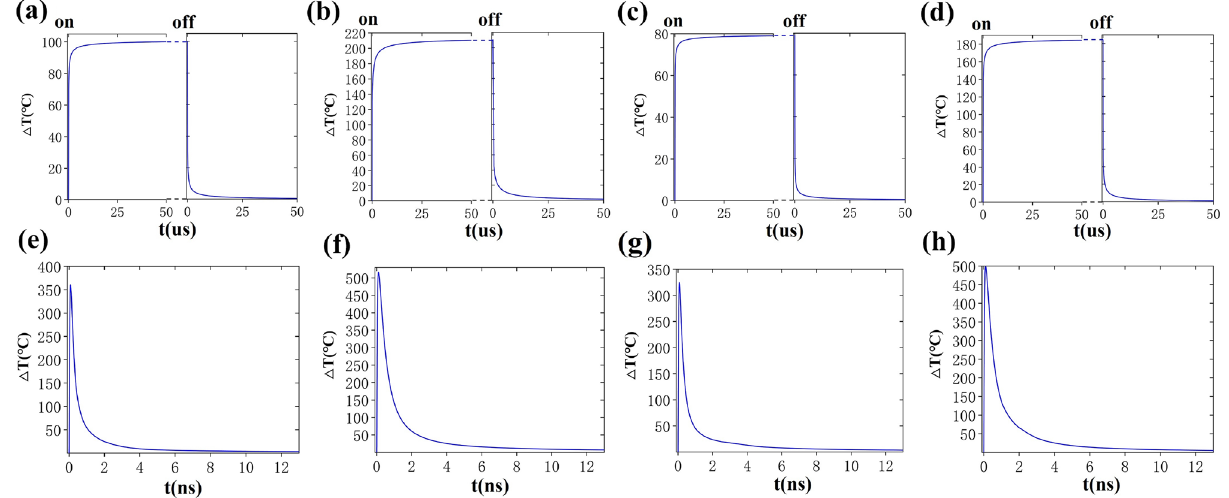
Figure 8. The max transient temperature increasement of gold nanoclusters in water excited by on–off modulated continuous Gaussian light (spot radius = 1000 nm, power = 3.4mW): ( a ) GNR (LSPR 760 nm) clusters at 760 nm laser excitation; ( b ) GNB (LSPR 760 nm) clusters at 760 nm laser excitation; ( c ) GNR (LSPR 780 nm) clusters at 780 nm laser excitation; ( d ) GNB (LSPR 780 nm) clusters at 780 nm laser excitation. The max transient temperature increasement of water around gold nanoparticle clusters excited by fs laser in a pulse period (pulse width t l = 120 fs, power = 1mW, pulse frequency = 76 MHz). ( e ) GNR (LSPR 760 nm) clusters at 760 nm laser excitation; ( f ) GNB (LSPR 760 nm) clusters at 760 nm laser excitation; ( g ) GNR (LSPR 780 nm) clusters at 780 nm laser excitation; ( h ) GNB (LSPR 780 nm) clusters at 780 nm laser